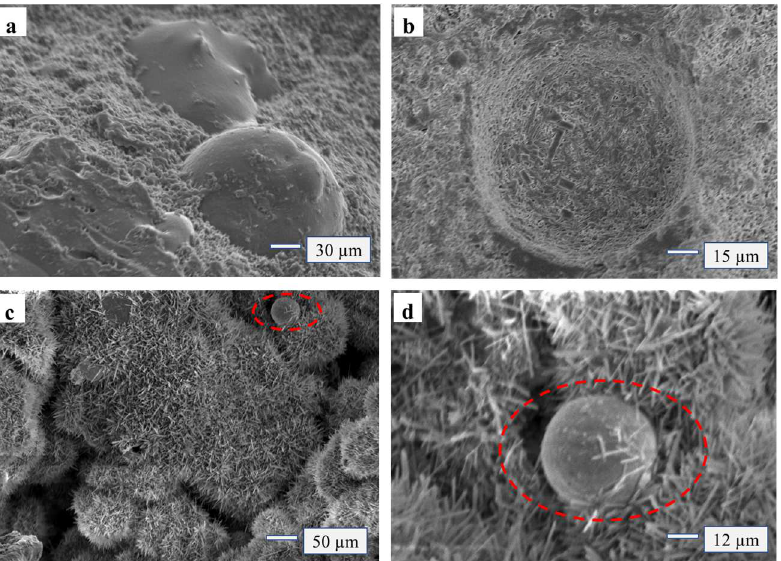
Figure 4. SEM of 5-phase crystallization and Si from FA. ( a, b ) EDS for different areas and magni- fications; ( c ) the spherical Si molecule of FA; ( d ) the spherical Si molecule of FA.